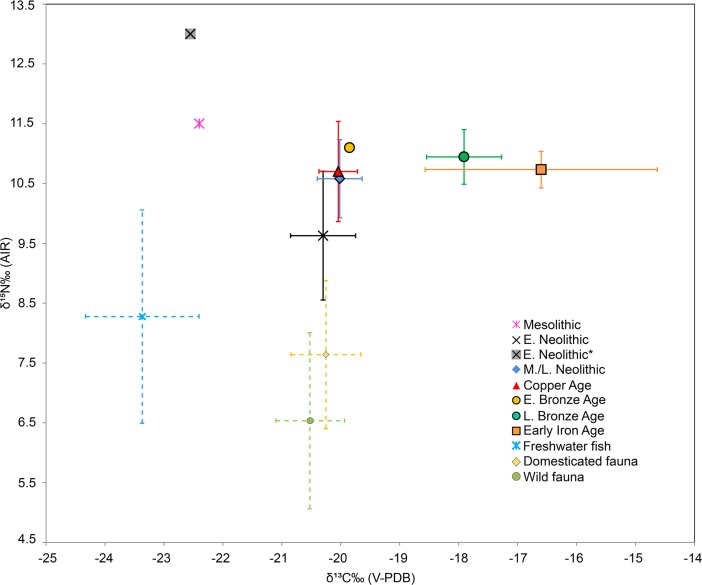
Stable carbon and nitrogen isotope data of human and faunal bone collagen from the GHP.Both human and fauna isotopic data are represented by mean isotopic values (standard deviation ±1σ indicated by bars). Domesticated and wild fauna belongs to Early/Middle Neolithic and Copper Age periods, and combined with published data [22,25,42,76]. Human results from this study were also combined with previous published data in the GHP [22,25,76]. E. Neolithic* represent mean values of Körös Tiszaszőlős-Domaháza site.